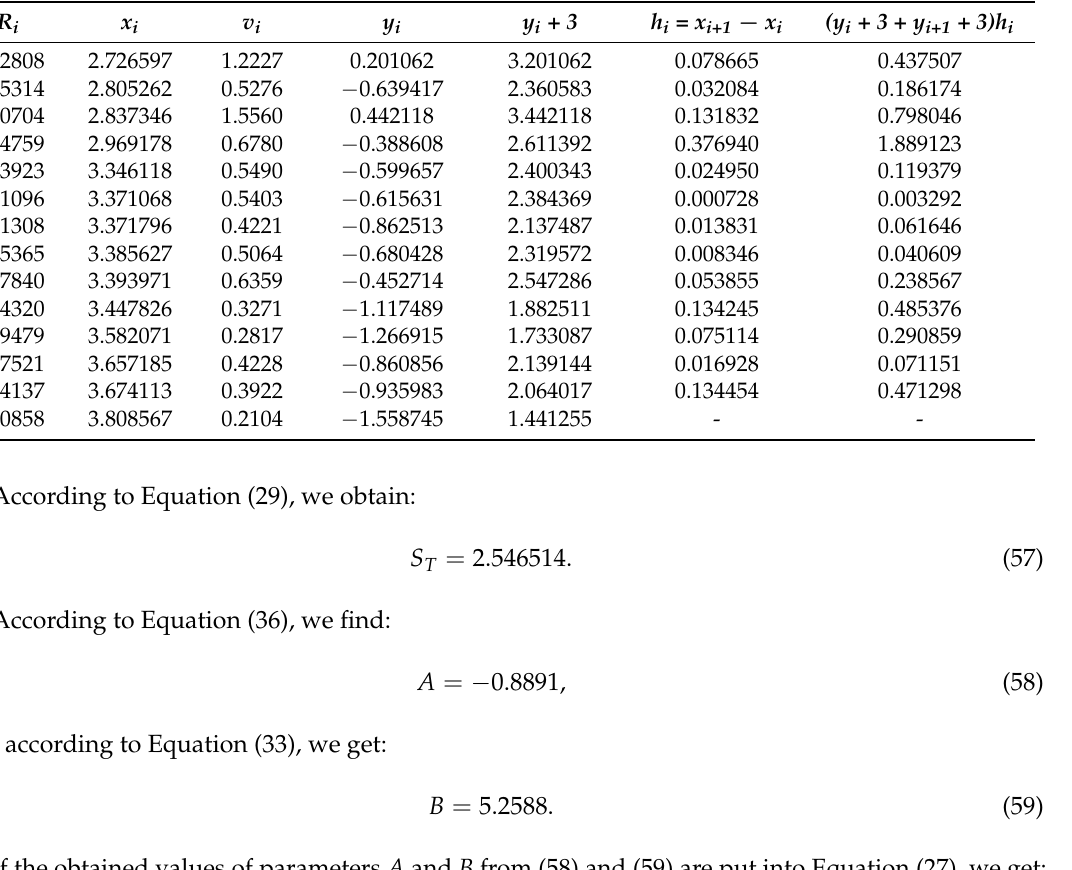
Table 6. Representation of data for calculating the parameters in Nepriˇcava open pit according to Model